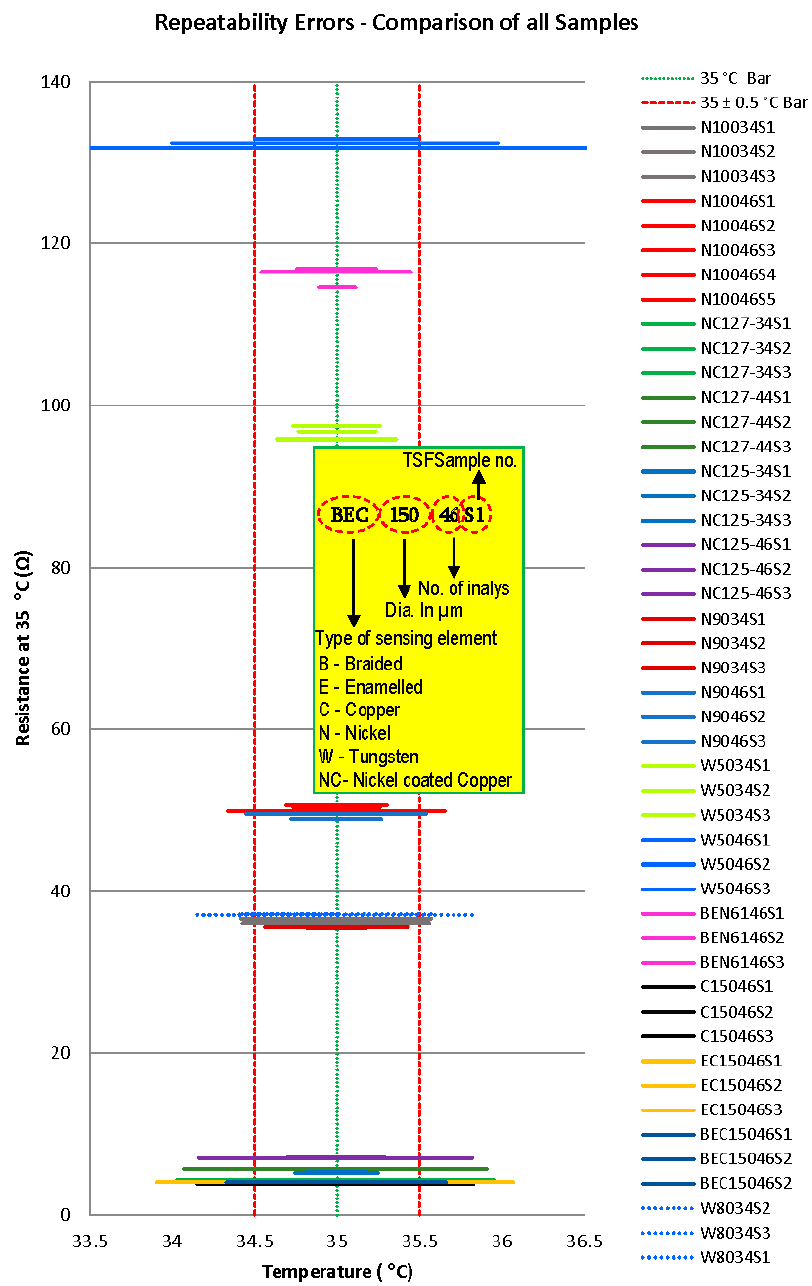
Figure 21. Repeatability uncertainty—comparison of all TSF samples.